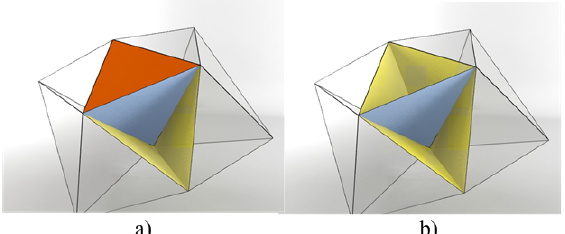
Figure 5. Illustration of Constraint I (a) a candidate tetrahedron with a fixed triangular facets; b) the carving results in a dangling triangle which breaks the constraint I)